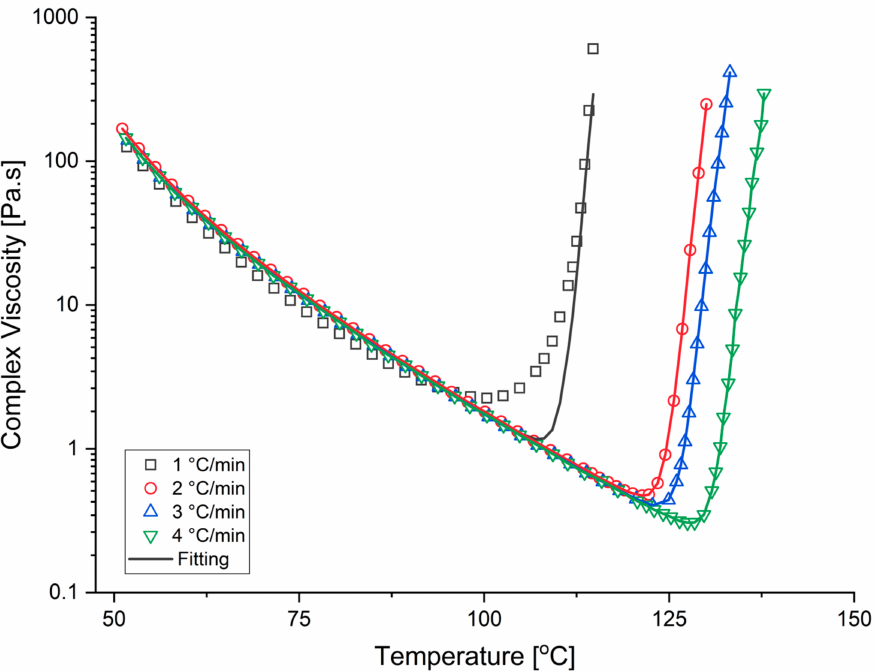
Figure 5. Experimental (symbols) and model predictions (continuous lines) for complex viscosity profiles under dynamic conditions (For an interpretation of the references to the colors in this figure’s legend, the reader is referred to the web version of this